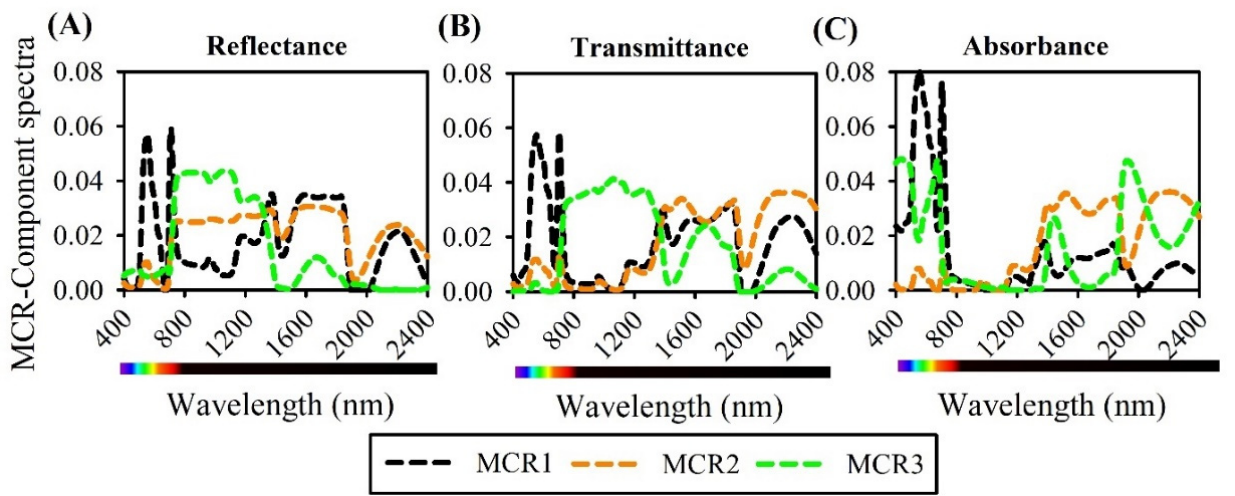
Figure 7. Major contribution of multivariate curve resolution (MCR) component of hyperspectral ( A ) reflectance, ( B ) transmittance, and ( C ) absorbance (400–2400 nm) of lettuce plants (n = 600).